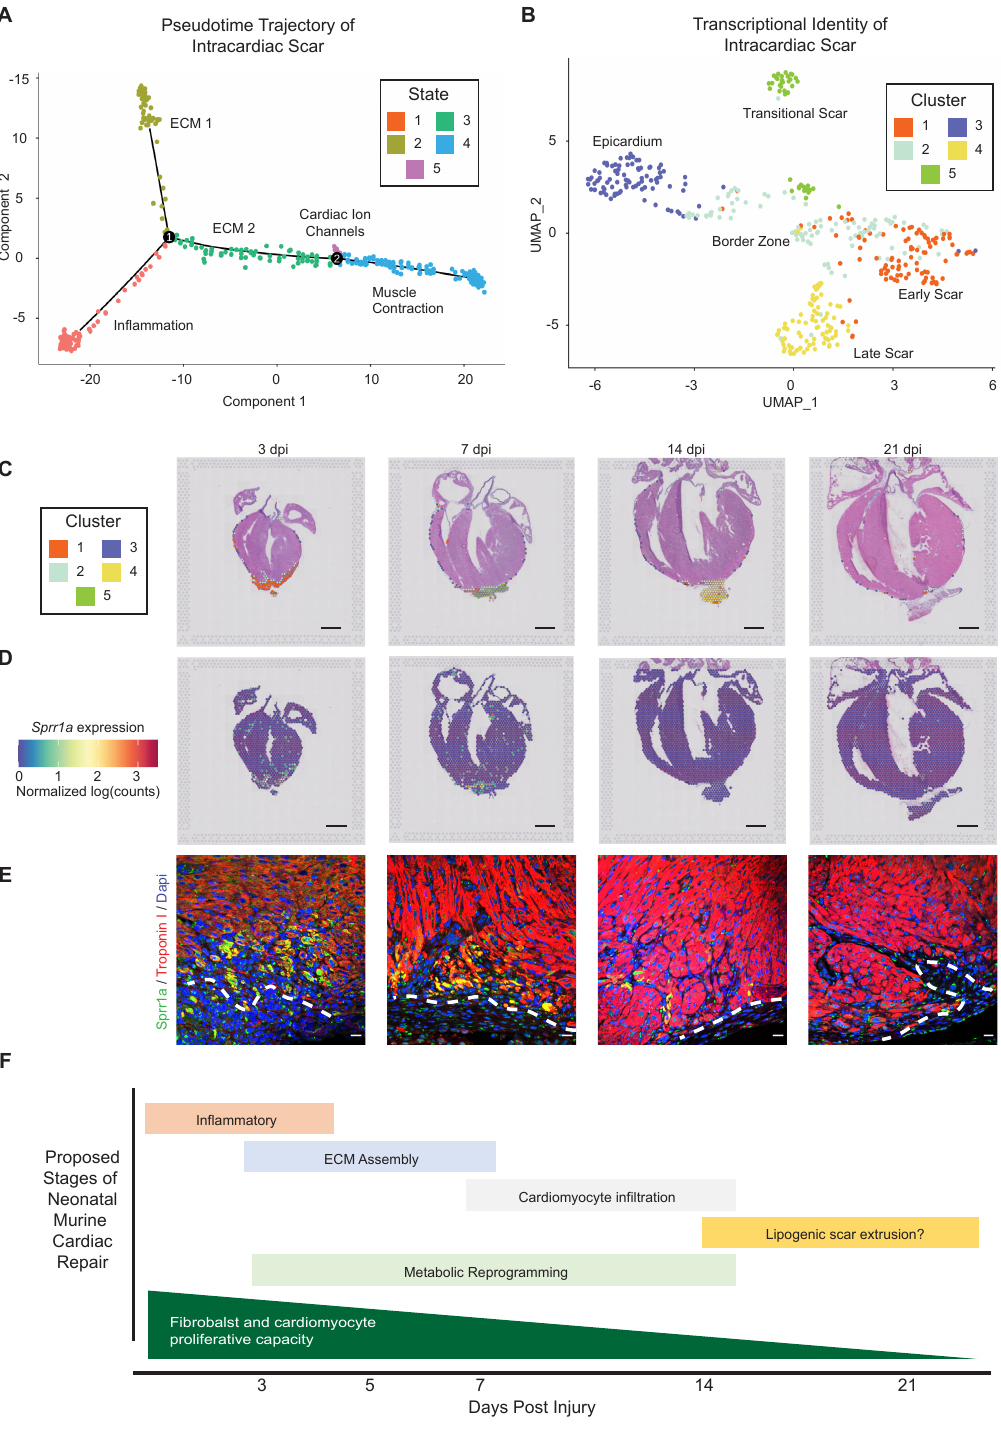
Figure 7. Spatial transcriptomics reveals the phenotypic trajectory of the intracardiac resolving intracardiac scar and border zone. ( A ) Pseudotime developmental trajectory was integrated with biological